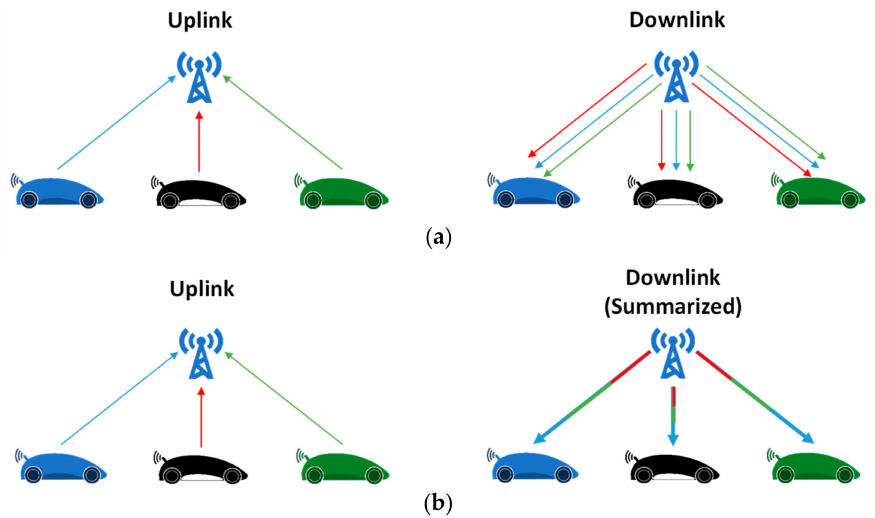
Figure 6. Fusion of events by mobile edge computing (MEC) ( a ) simple / flooding scheme; ( b ) smart fusion enabled to reduce redundant